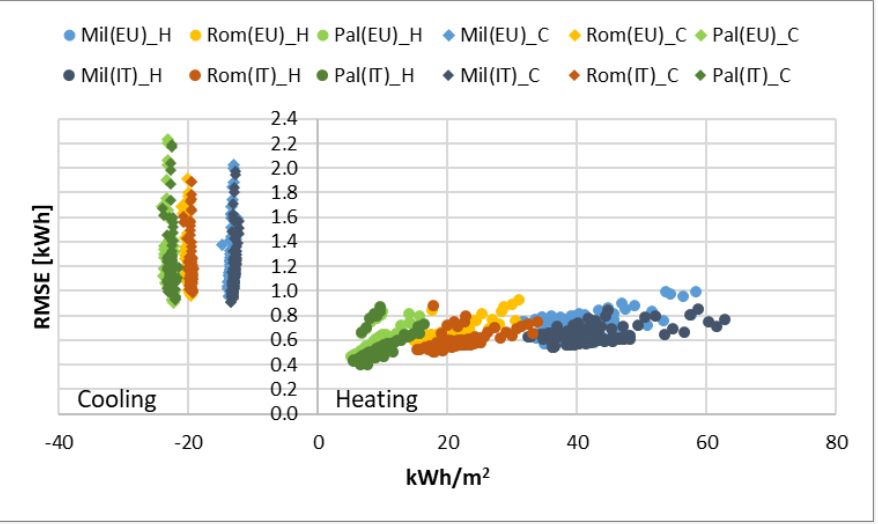
Figure 10. RMSE for heating and cooling needs, for all climates of the case study and for both methods (EU: Annex B, IT: Annex A): Case study with g gl,n = 0.34.